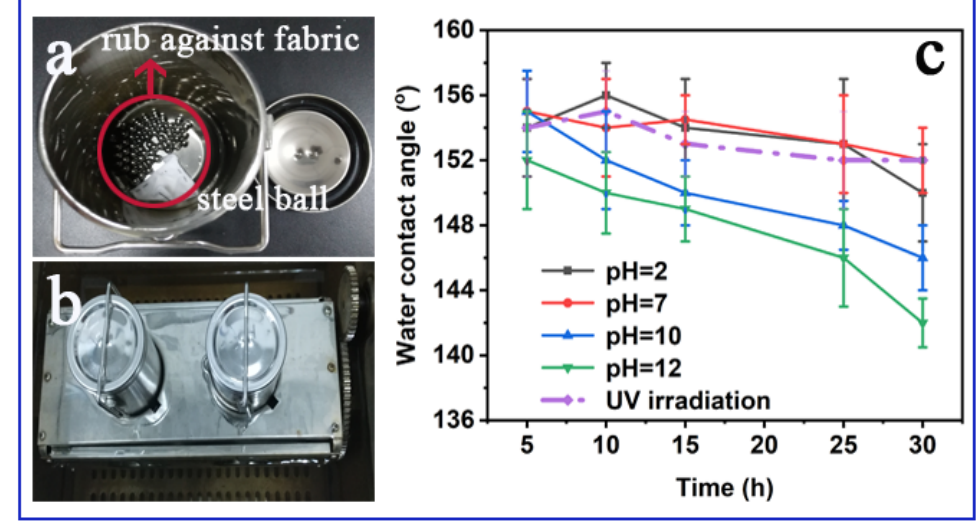
Figure 3. ( a , b ) Accelerated washing equipment; ( c ) variation of water contact angles (WCAs)